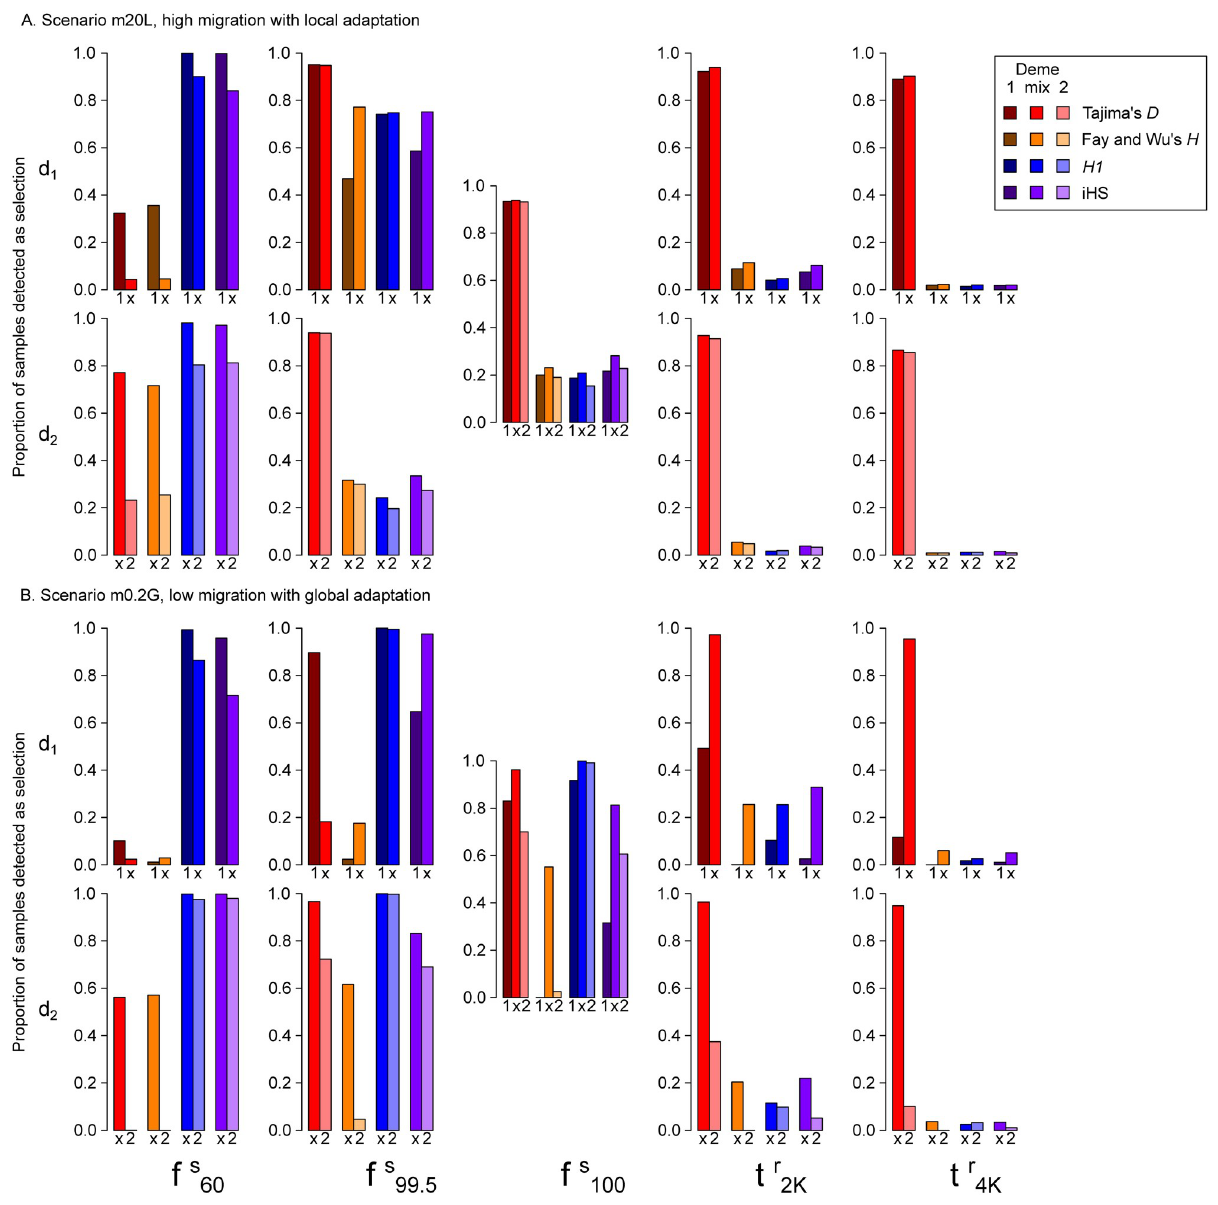
Fig 8. Full-locus simulation: Comparing summary statistic detection rate of sweeps between deme-specific samples and mixed samples. The proportion of samples detected as sweeps from d 1 , mixed samples and d 2 (noted below the bars as “1”, “x” and “2”) in various time stages, for scenarios A: m20L, B: m0.2G. Different hues indicate different methods, and the shades represent d 1 , mixed and d 2 from dark to light. f s shared by both demes, thus the graph in the middle contains results from d 1 , mixed and d 2 . The other four time points are deme-specific, thus we must compare only one deme with mixed